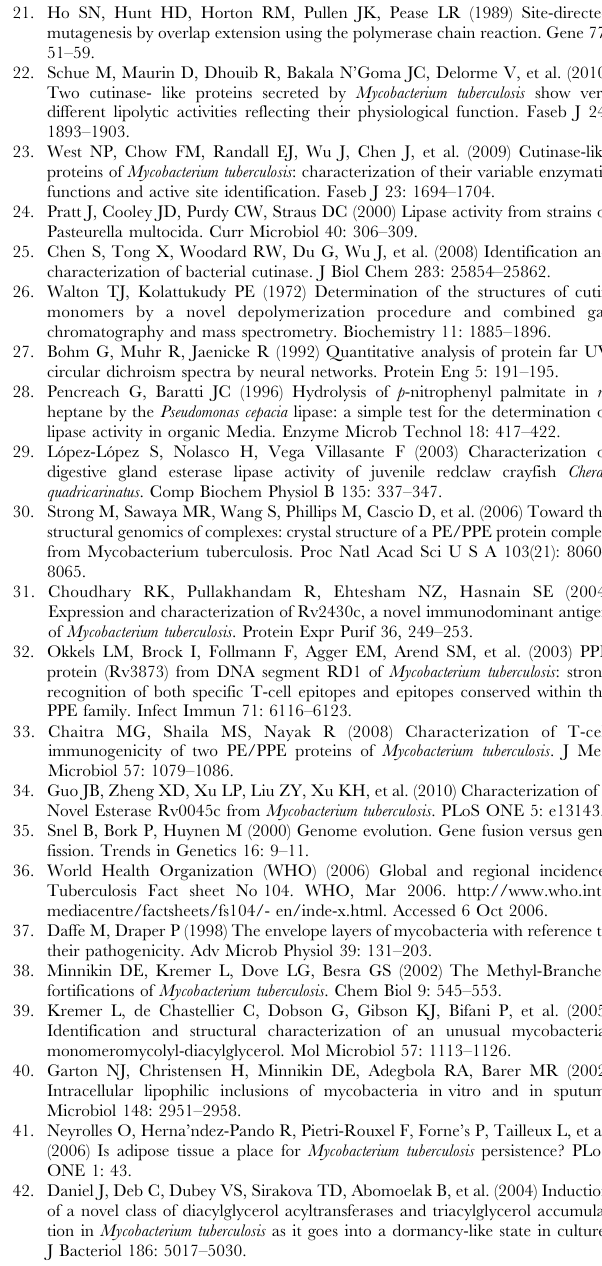
Figure S1 Cloning of Rv1430c (1601 bp) and its PE-PPE domain (678 bp) in vector pET-28a. (A) Agarose gel electropho- resis analysis after restiction digestion of the insert Rv1430 in pET- 28a (B) and Rv1430 PE-PPE domain in pET-28a. The vector and the insert bands are indicated by arrows. M: 1 kb molecular weight marker. Figure S2 Silver stained SDS–12% polyacrylamide gel electro- phoresis of the purified protein (A) Rv1430 full-length and (B) PE- PPE domain.